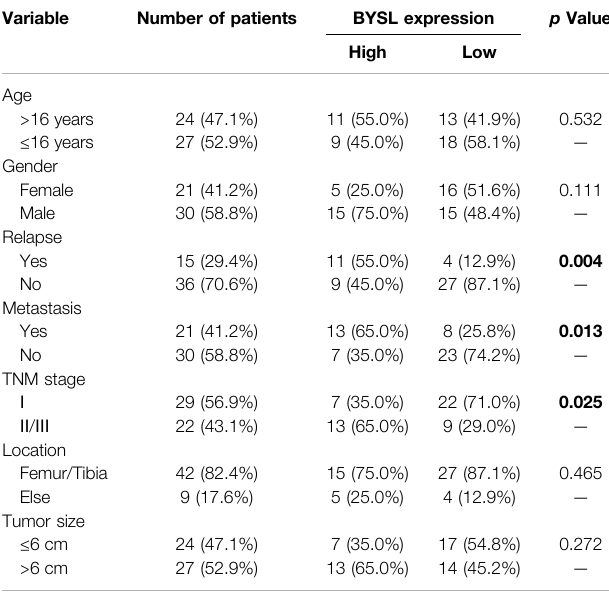
Note: Bold values indicate p <